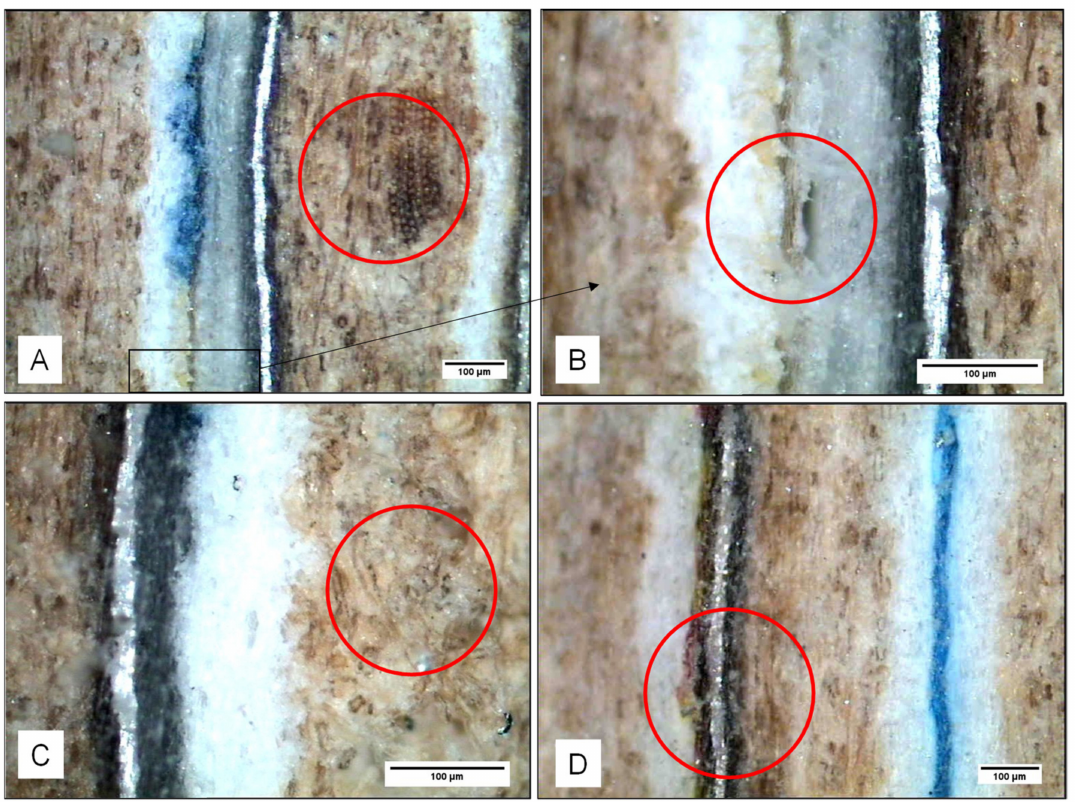
Figure 18. Some of the common failures in the samples before tests: ( A ) and ( B ) lack of adhesion PE–PE, which provokes isolated porosity, ( C ) intrinsic porosity cardboard (cellulose) and ( D ) failure between PE and printing